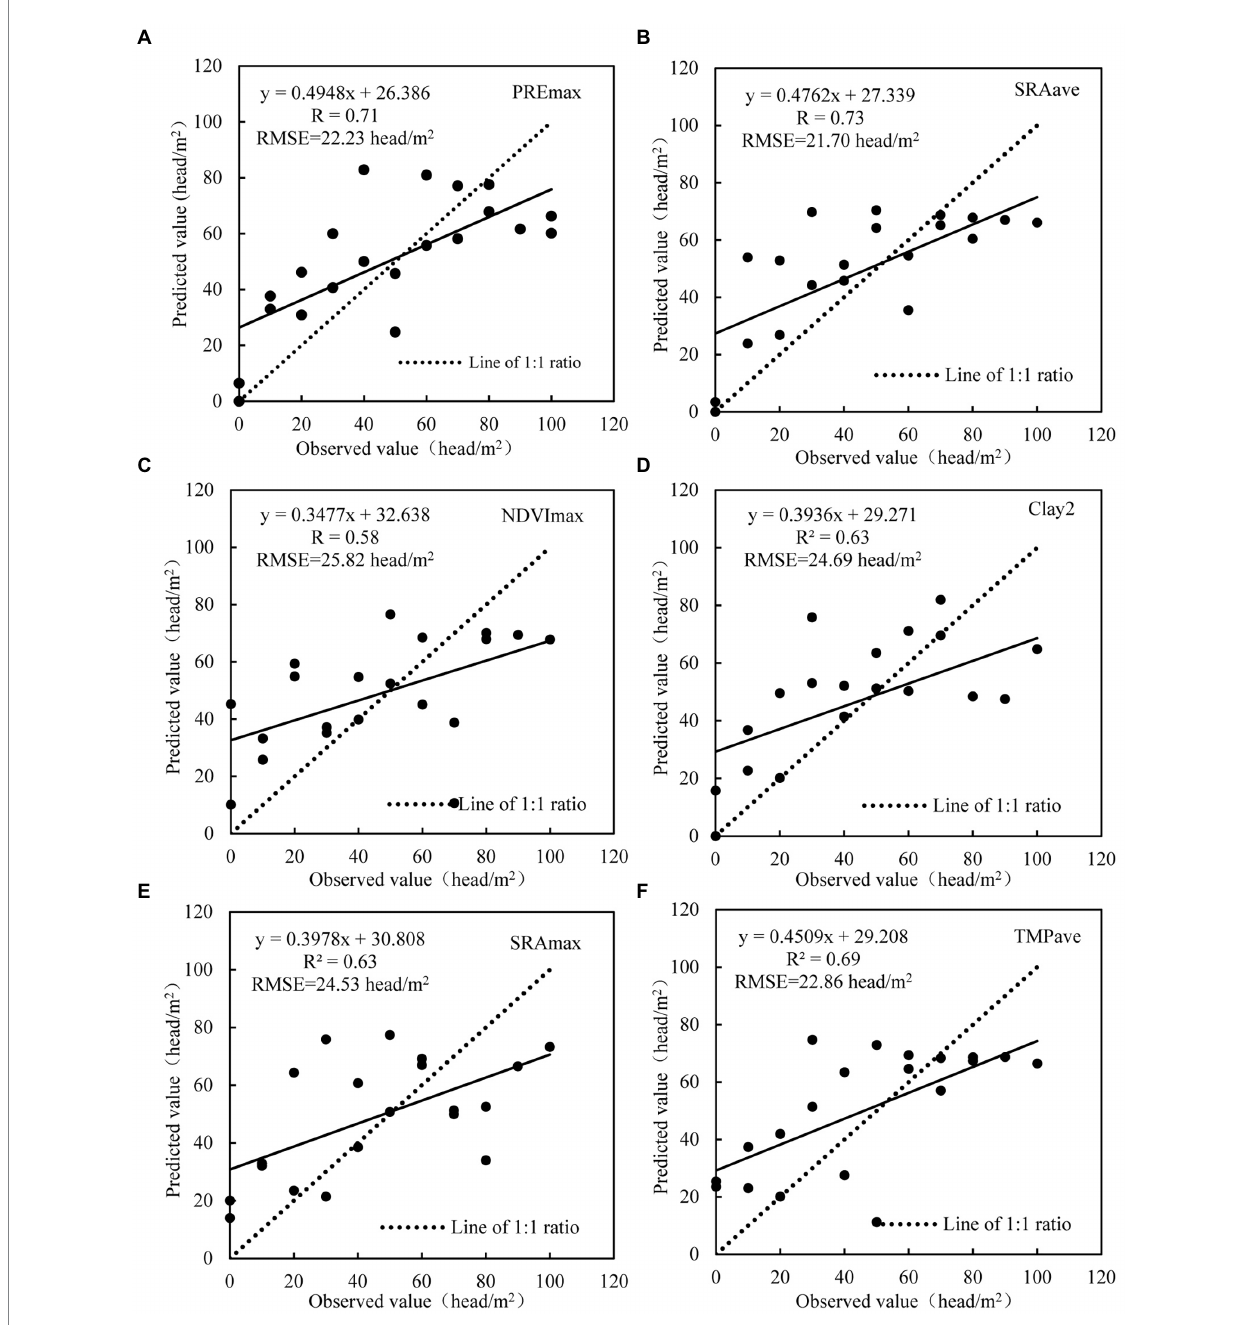
FIGURE 4 The relationship between the observation value and predicted value. (A-F) refers to the maximum precipitation (PREmax), average solar radiation (SRAave), maximum NDVI (NDVImax), clay concentration of bottom soil (Clay2), maximum solar radiation (SRAmax), and average temperature (TEMave),